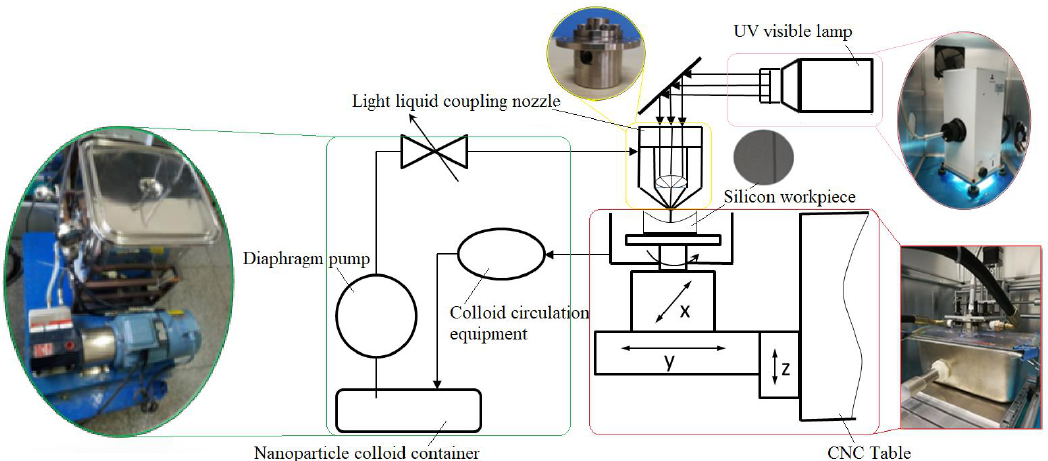
Figure 17. The system diagram of ultraviolet induced nanoparticle colloid jet machining.